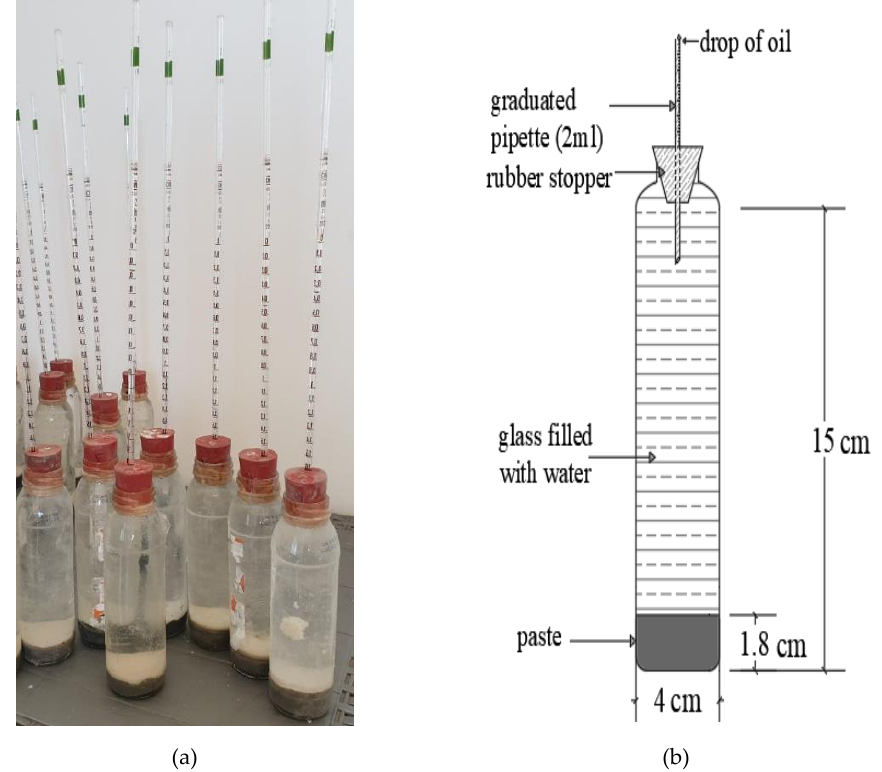
Figure 2. ( a ) Chemical shrinkage specimens. ( b ) Chemical shrinkage test